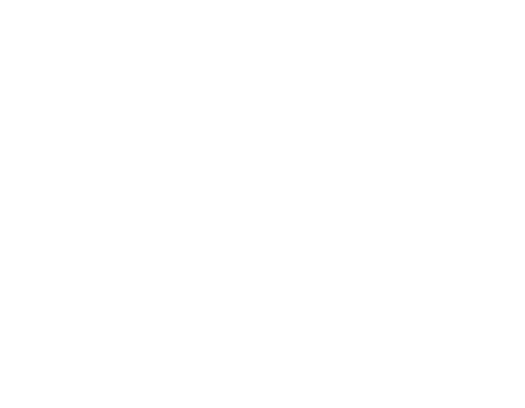
Figure 5. Inhibitory effect of rhodoxanthin at five different concentrations (C1–C5) on HaCaT cells. Ctrl—untreated cells. Values represent the mean ± SD of three determinations. p >